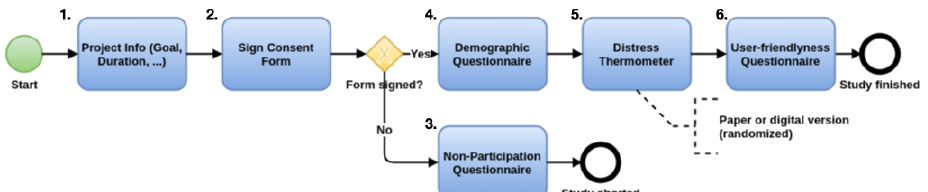
Figure 6. Process diagram of the pilot study procedure. The goal of the study was introduced (step 1, blue boxes) and individuals had to sign a consent form (2). If consent was not provided, individuals were asked to fill in a form regarding why they would not like to participate (3) and then had their regular counseling hour. If consent was provided, they were asked to provide demographic information (4) and fill in the Distress Thermometer (5) either on paper or on the tablet (choice was randomized). Finally, they had to give feedback regarding our four evaluation criteria (6), before they moved on with the regular counseling